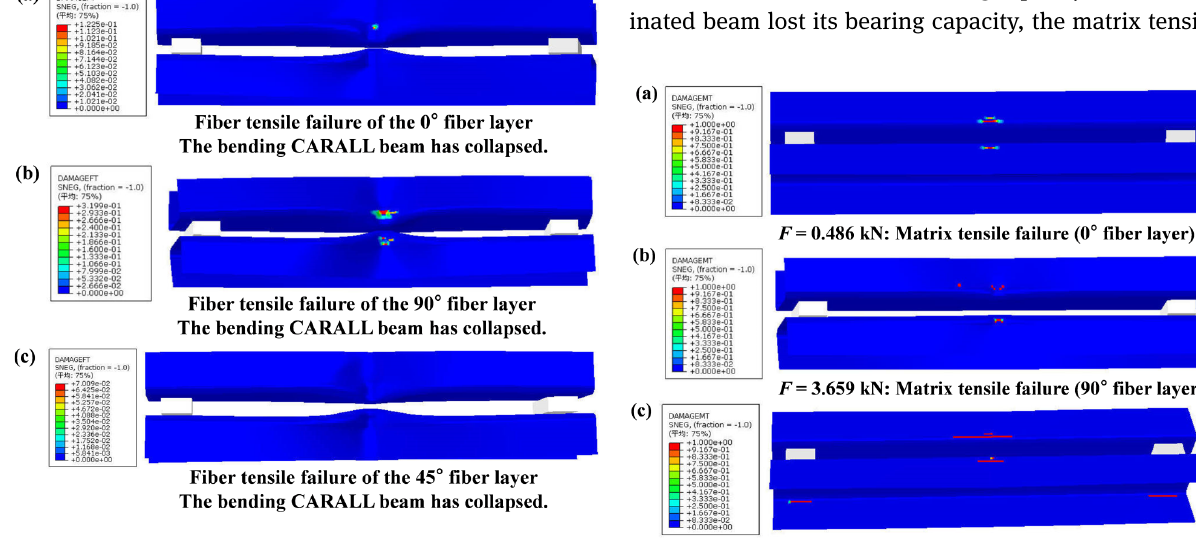
Figure 15: Failure evolution process of fiber tension in CFRP layers of double-channel CARALL beam: (a) SHCXL-A: 0 ∘ fiber layer; (b) SHCXL-A: 90 ∘ fiber layer; and (c) SHCXL-B: 45 ∘ fiber layer.